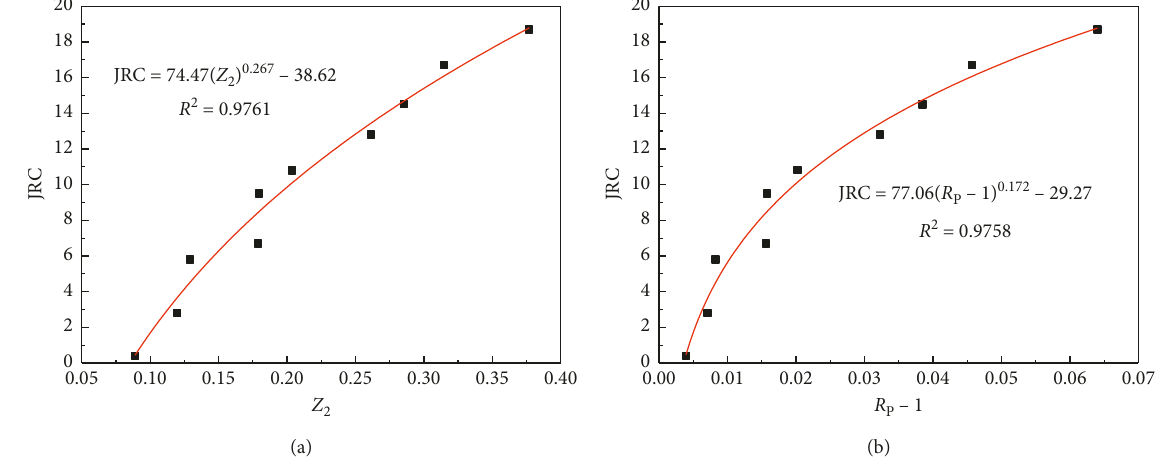
Figure 7: Fitting curves between statistical parameters and JRC. (a) Z Table 2: Comparison of relationships of Z